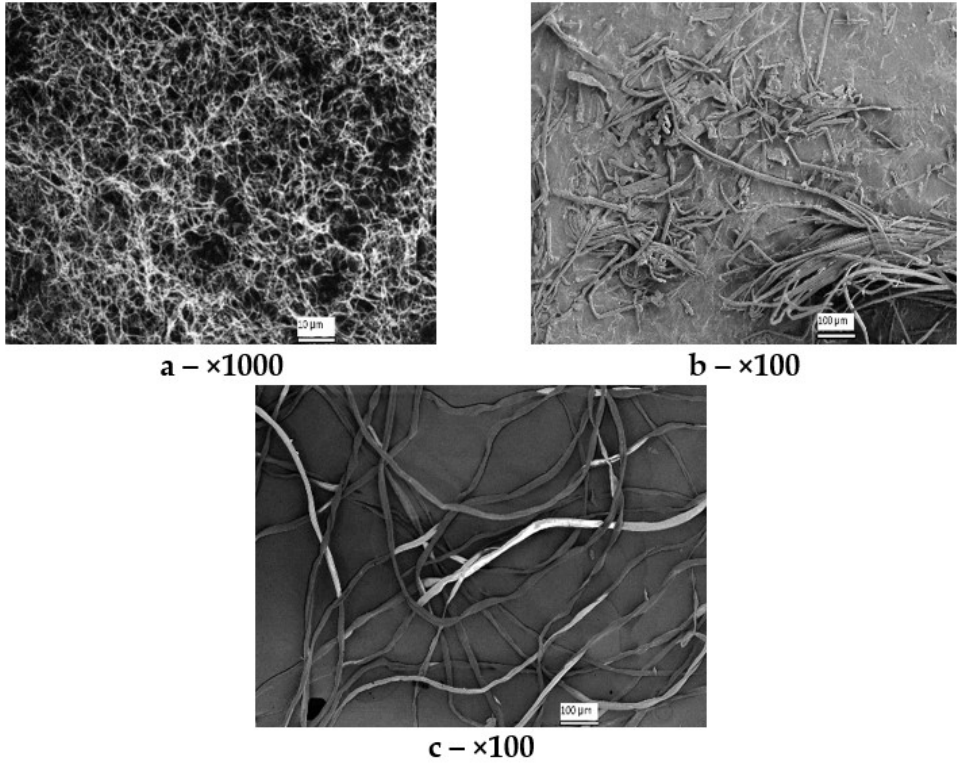
Figure 3. SEM images of cellulose samples of different origin: ( a ) BC, ( b ) synthetic cellulose, and ( c ) ( c ) Miscanthus Miscanthus cellulose.